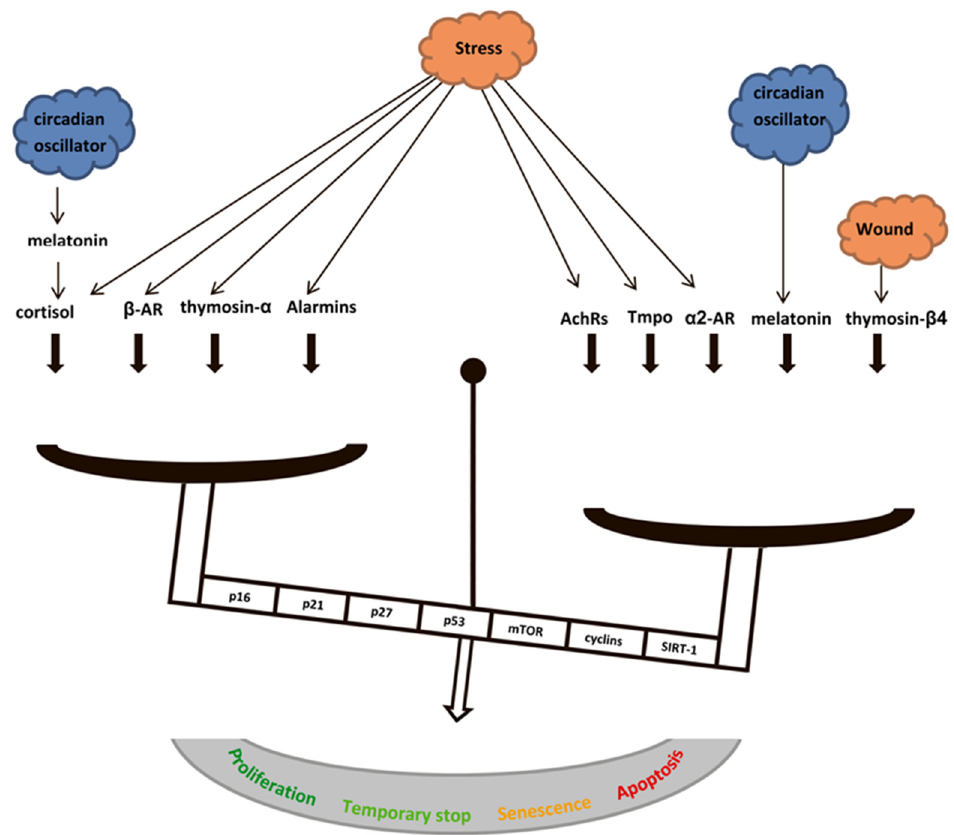
Figure 9. Hypothetic scheme showing the balancing effects of immune response regulators on signalling pathways that control cell cycle, senescence, and apoptosis. β AR— β -adrenoreceptors; AchRs—acetylcholine receptors; α 2AR— α 2-adrenoreceptors; Tmpo—thymopoietin.